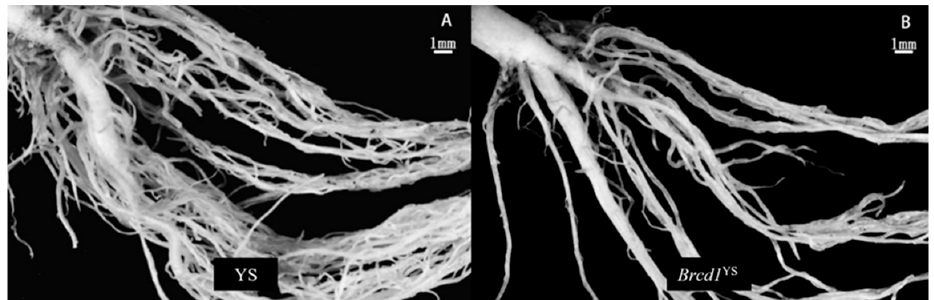
Figure 2. Phenotype characterization of Brcd1 YS and YS. The plant height, leaf length, and leaf width were used for the phenotypic characterization of Brcd1 YS and YS, all the traits presented a normal distribution. ( A ): plant height, ( B ): leaf length, ( C ): leaf width. Data are shown as presented the mean ± SD ( n = 10 plants). * p < 0.05. ** p < 0.01.